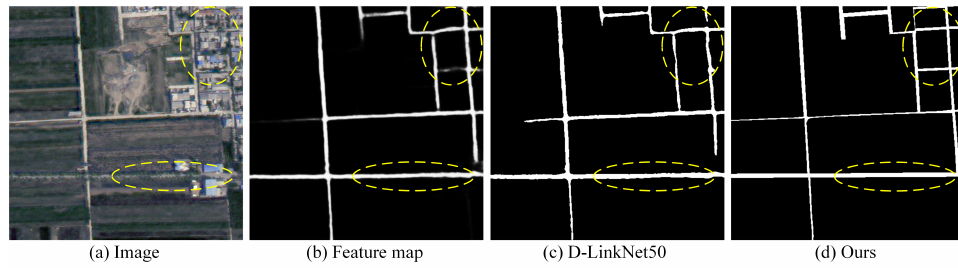
Figure 6. Comparison of results of the existing threshed-based method and